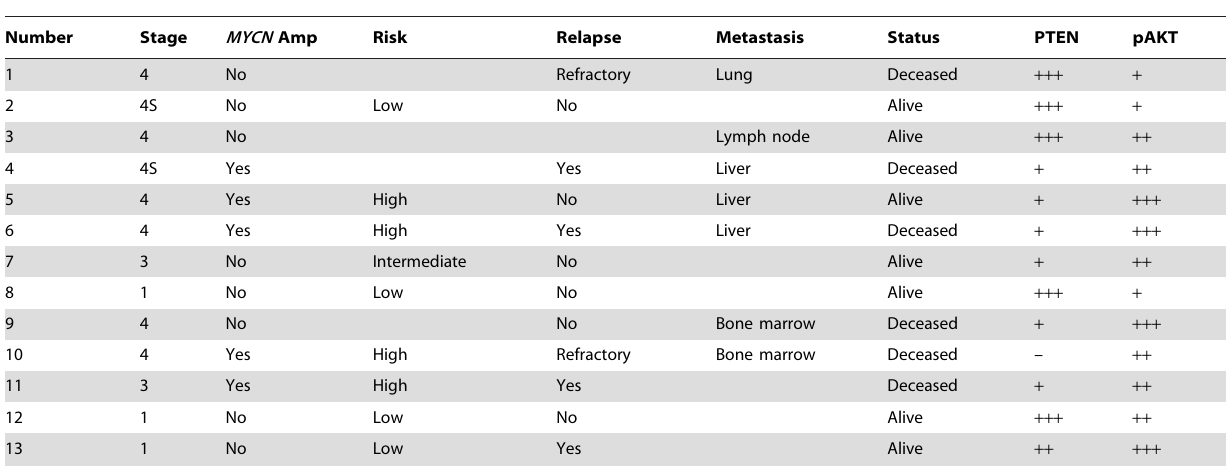
Table 1. PTEN and pAKT expression patterns in human neuroblastoma sections.